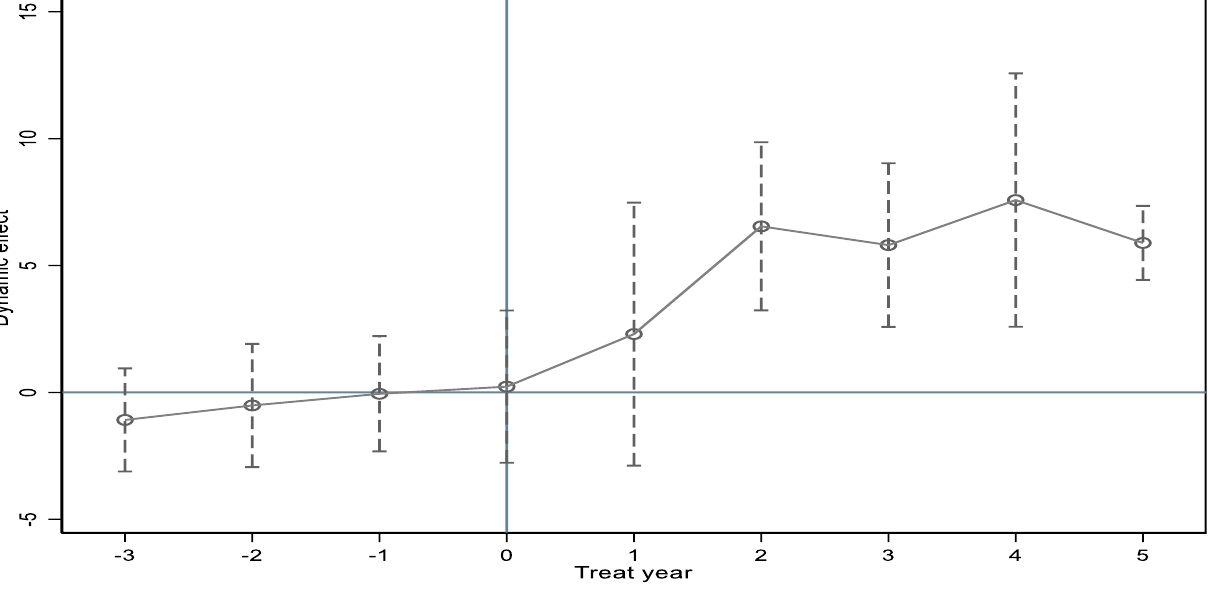
Figure 4. The pre − trend test of the CCU policy.